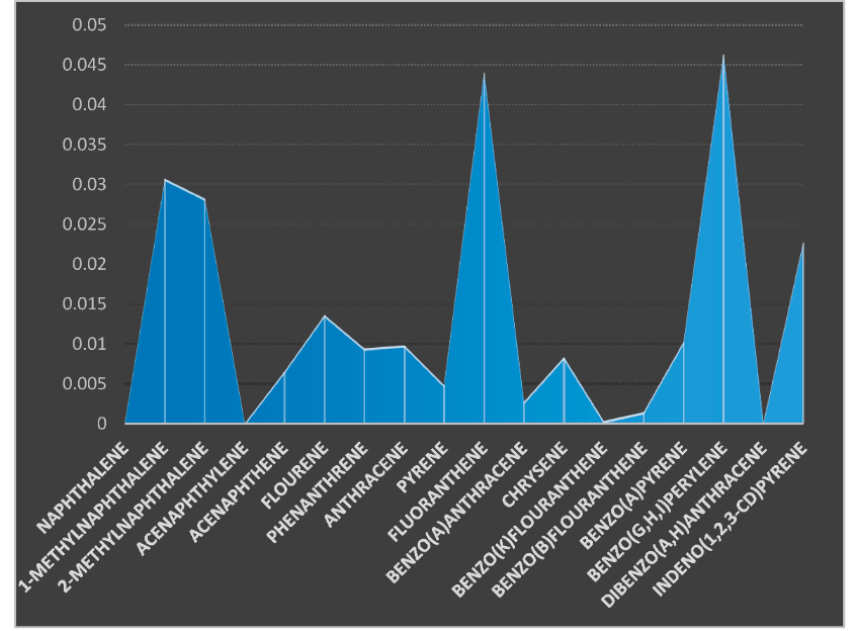
Figure 2. Concentration of PAHs (µg/kg) components in the soil sample from location 1.